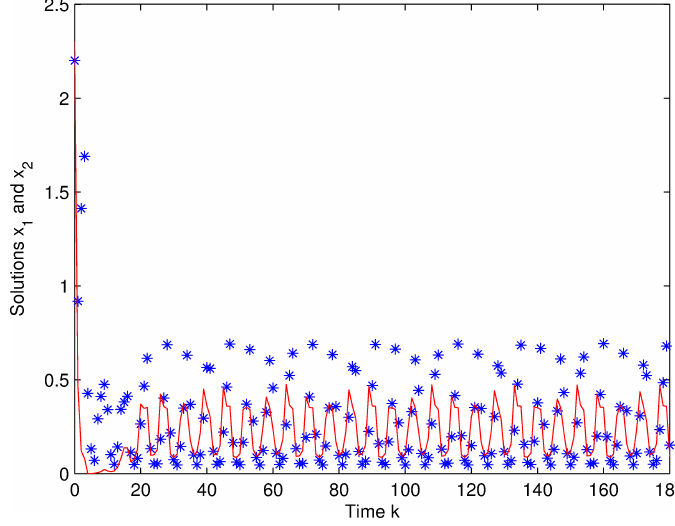
Fig. 3. Times series of x 1 and x 2 for system (74) , where the blue line stands for x 1 and the red line stands for x 2